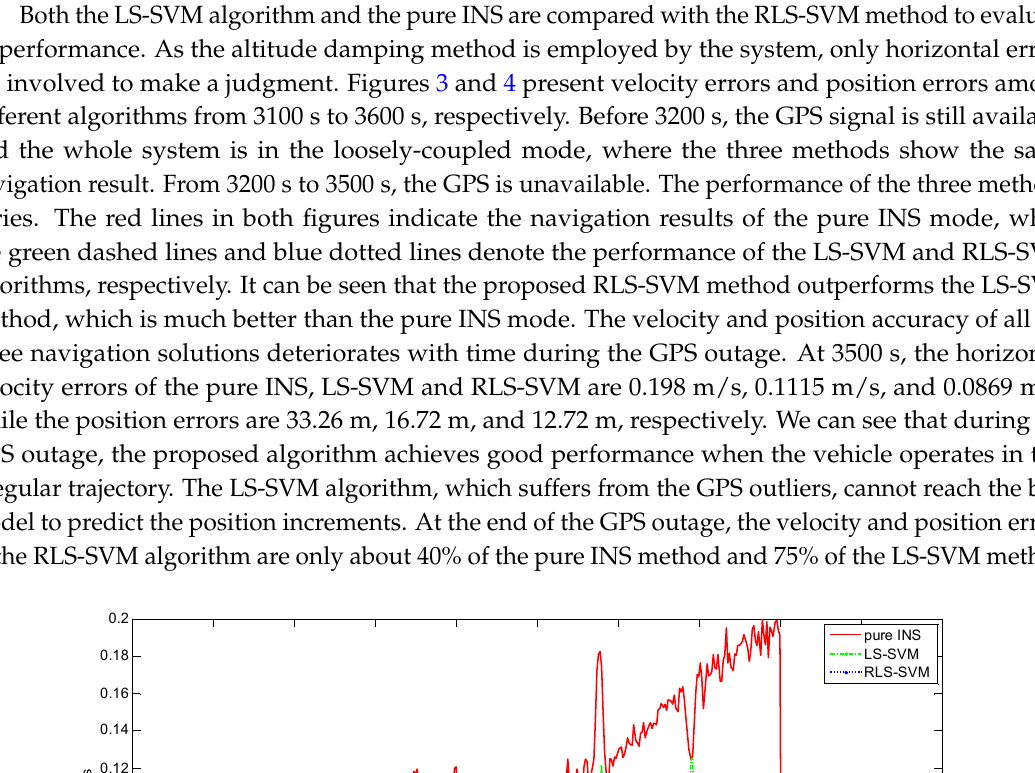
Figure 4. Position errors among different algorithms. When the GPS signal is recovered at 3500 s, the whole system switches to the loosely-coupled mode again. The position error and velocity error quickly converges and the navigation results of the three methods are approaching the same along with time. As the position difference of the INS and the GPS are directly the observation vector of the KF, the position errors of the three methods has little difference after 3500 s, while the velocity errors differ slightly, but converge towards one another. During the training period, where the first 2300 s data is trained and investigated, the 2300 s data is separated into two data sets. The training set includes the data from 900 s to 3000 s, which is used to train the LS-SVM and RLS-SVM models. The validation set involves the data from 3001s to 3200 s, which is utilized to validate the effectiveness of the trained models. Thus, the effectiveness of the prediction of the position increments of the two models can be compared on the validation set, which is shown below. Figures 5 and 6 are prediction errors of the position increment of the two algorithms in latitude and longitude, respectively. The red dotted lines are the results of LS-SVM, while the blue lines show the performance of the proposed algorithm. The mean values of the prediction error using LS-SVM and RLS-SVM are